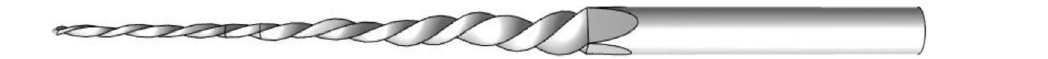
Fig. 3 ProTaper NEXT 3D model